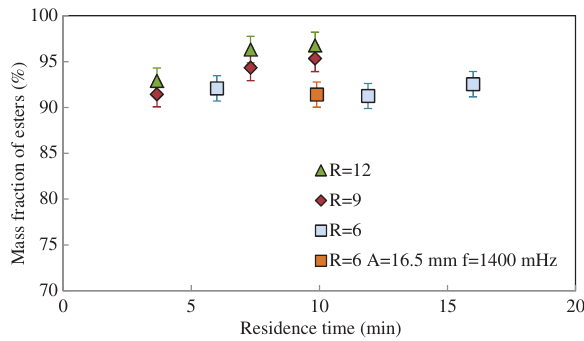
Figure 6 Variation of the methanol-to-oil molar ratio at 44 ° C, A = 16.5 mm and f = 1050 mHz. An experiment was also carried out at A = 16.5 mm and f = 1400